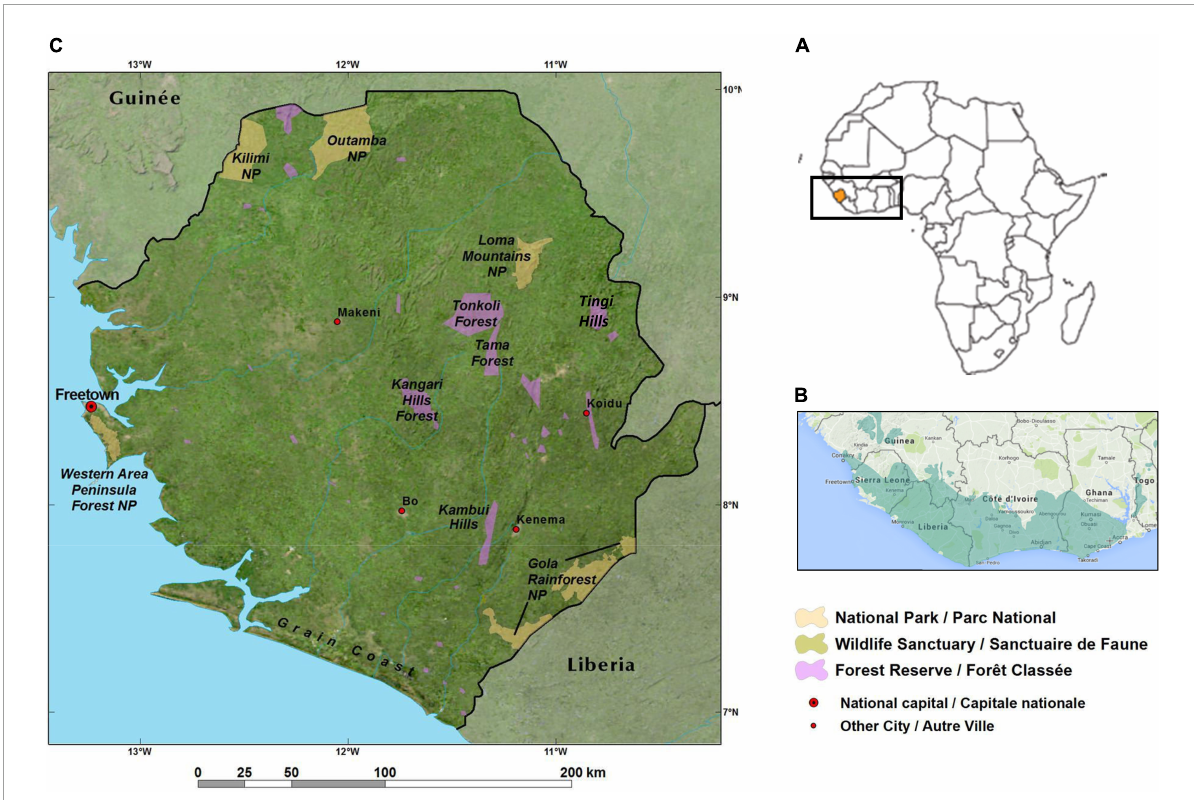
FIGURE1 (A) Location of Sierra Leone (colored) in West Africa; (B) Extent of the Upper Guinea forest in West Africa (area shaded in green); and (C) Map of Sierra Leone showing National Parks and Forest Reserves [Sources of maps: (A) Mapsland, https://www.mapsland.com; (B) Global Forest Watch, https://www.globalforestwatch.org; (C) U.S. Geological Survey,